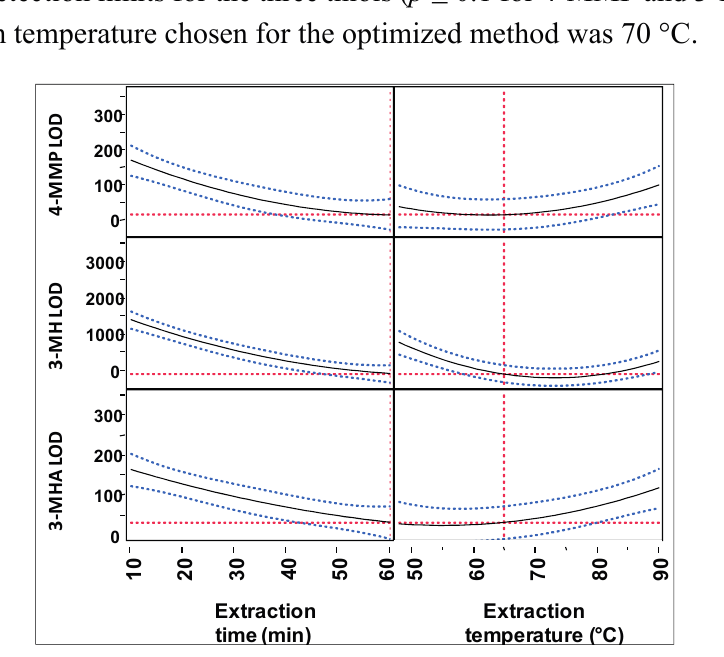
Figure 4. Effect of extraction temperature and extraction time on detection limits for thiols. The optimization was performed using a multifactorial CCF model. The red dotted lines show the mean values within a factor ( vertical lines ) or for a thiol detection limit ( horizontal lines ). The blue dotted lines represent the error